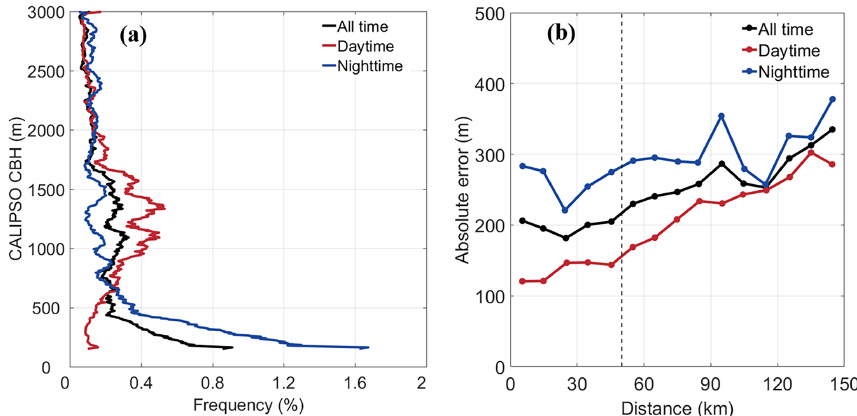
Figure A4. (a) Frequency profile of CALIPSO-retrieved CBH of 138 continental ceilometer sites in the southern Great Plains in 2017– 2020. The different colored lines represent different times (the black line: all time; the red line: daytime; the blue line: nighttime). (b) Joint distribution of CBH absolute error (between CALIPSO CBH and ceilometer CBH) and distance (that is the shortest distance from the CALIPSO ground track to the ceilometer site) of 138 continental ceilometer sites in the southern Great Plains in 2017–2020. The different colored lines represent different times (the black line: all time; the red line: daytime; the blue line: